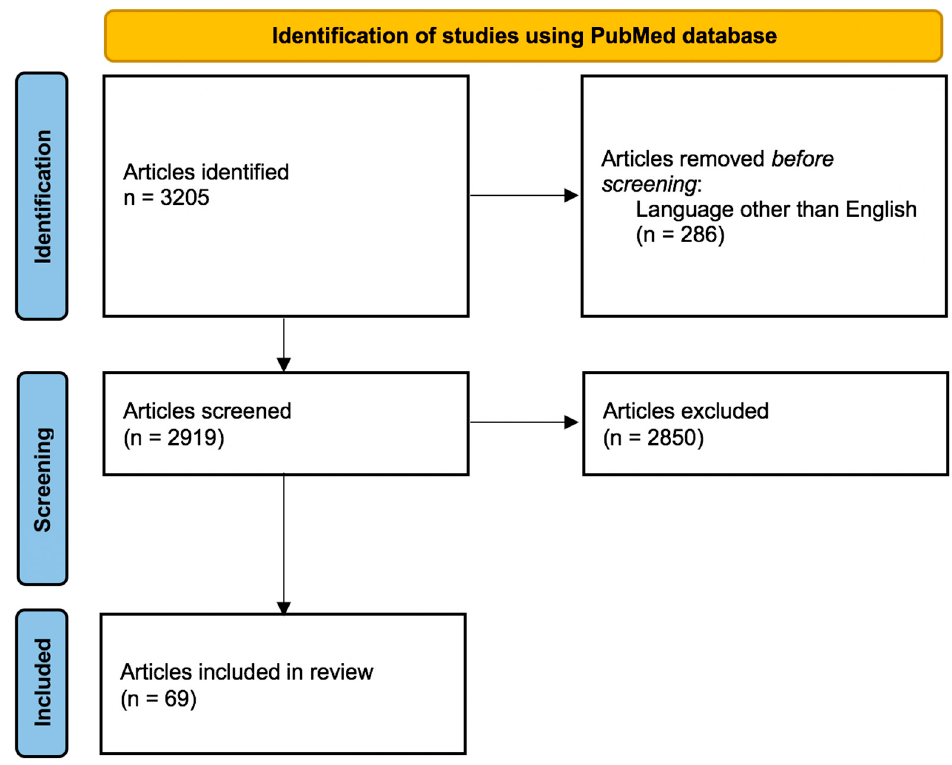
Figure 1. Flowchart showing methodology for the review of studies dealing with the factors affecting aseptic loosening in cementless total hip arthroplasty.